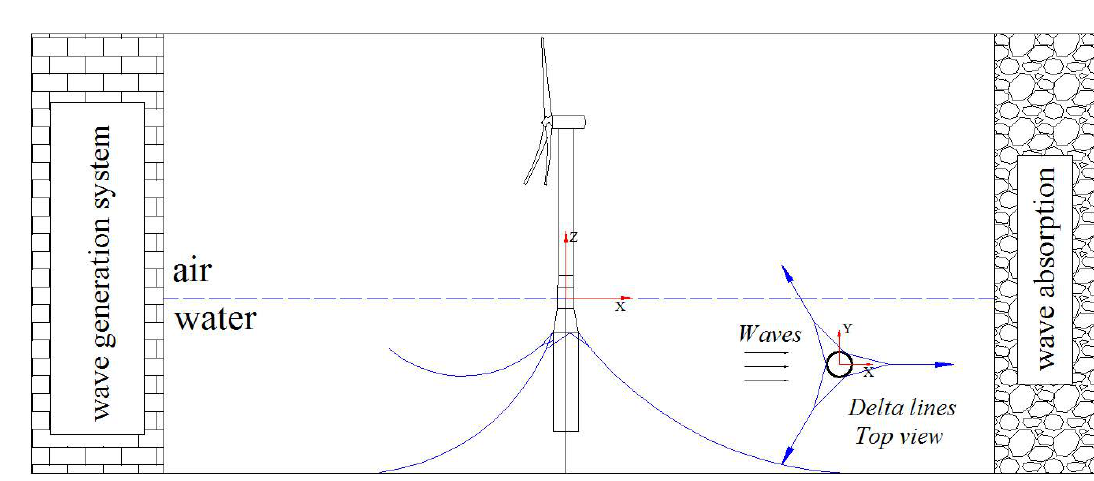
Figure 12. General layout for the experiment